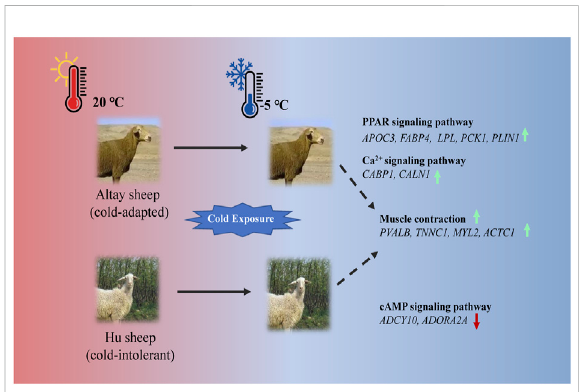
FIGURE 7 An illustration of genes involved in thermogenesis in cold- exposed Altay and Hu lambs. (A) : In cold-exposed Altay lambs, PPAR and calcium ion signaling pathway in muscle tissue were activated and differentially expressed genes (DEGs), such as APOC3, FABP4, LPL, PCK1, PLIN1, CABP, and CALN1 were up- regulated. (B) :Incold-exposedHulambs,cAMP signaling pathway was activated in muscle tissue and ADCY10, and ADORA2A were down-regulated. And the gene expression of PVALB, TNNC1, MYL2,andACTC1relatedtomusclecontractionwerehigherinthe muscle tissue of Altay than in Hu